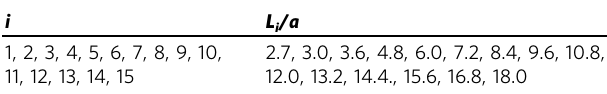
Table 1 Values of L i / a used used in all fi tting